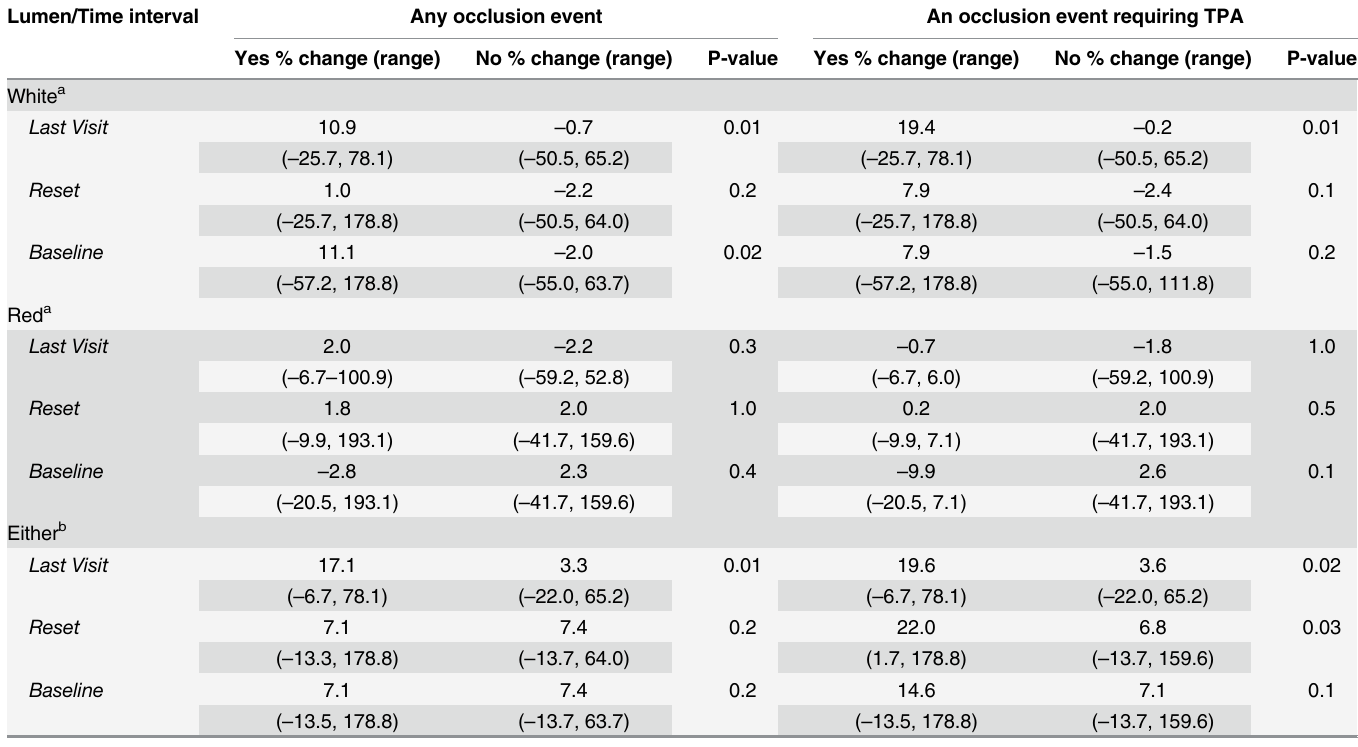
a Data represent the median proportional change in CVC pressure from the noted time point. b Data represent the median maximal proportional change in CVC pressure from the noted time